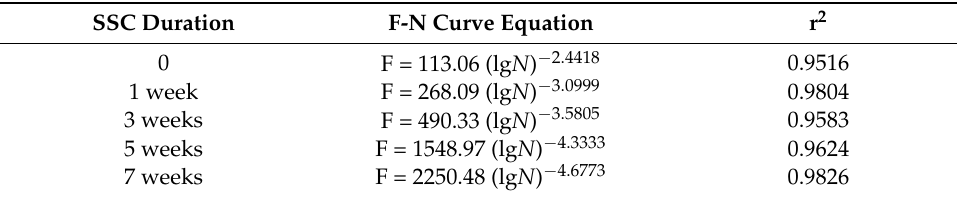
Table 3. F-N curve equation of the joints at different SSC